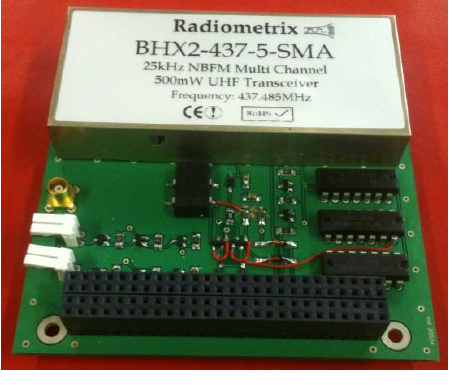
Figure 5. COMSYS board.